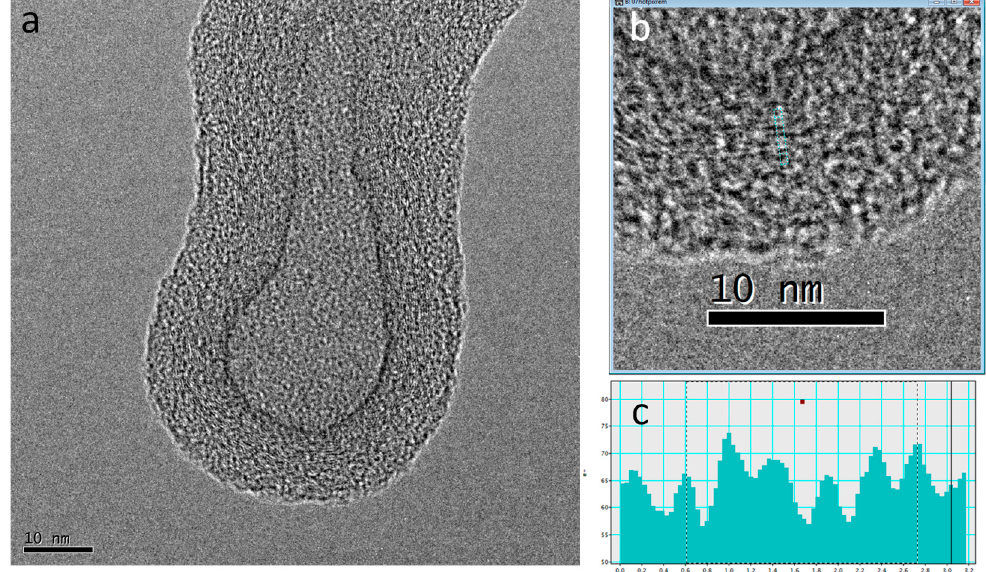
Figure 5. High resolution transmission electron microscopy (HRTEM) image analysis of a fingertip carbon shell. ( a ) Area of a finger-end, showing partially layered carbon structures closely parallel to the direction of the inner and outer surfaces of the fingertip; ( b , c ) highlights showing selected area with a fringe spacing of 0.42